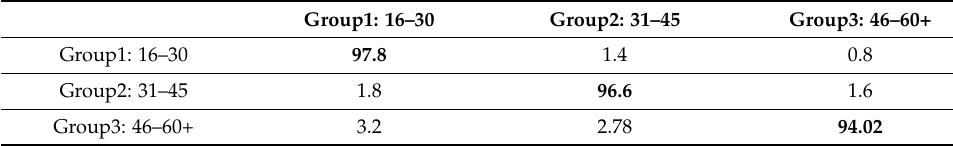
Table 5. Face age grouping confusion matrix in MORPH-II.